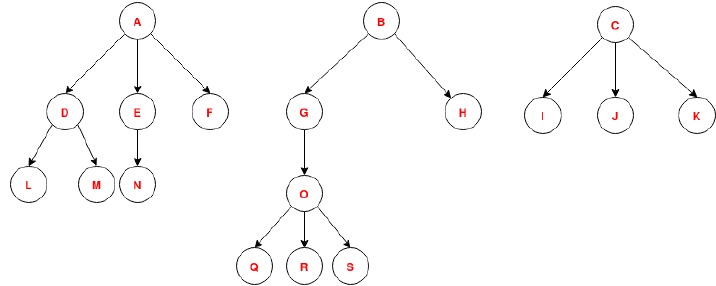
Figure 6. Deletion of